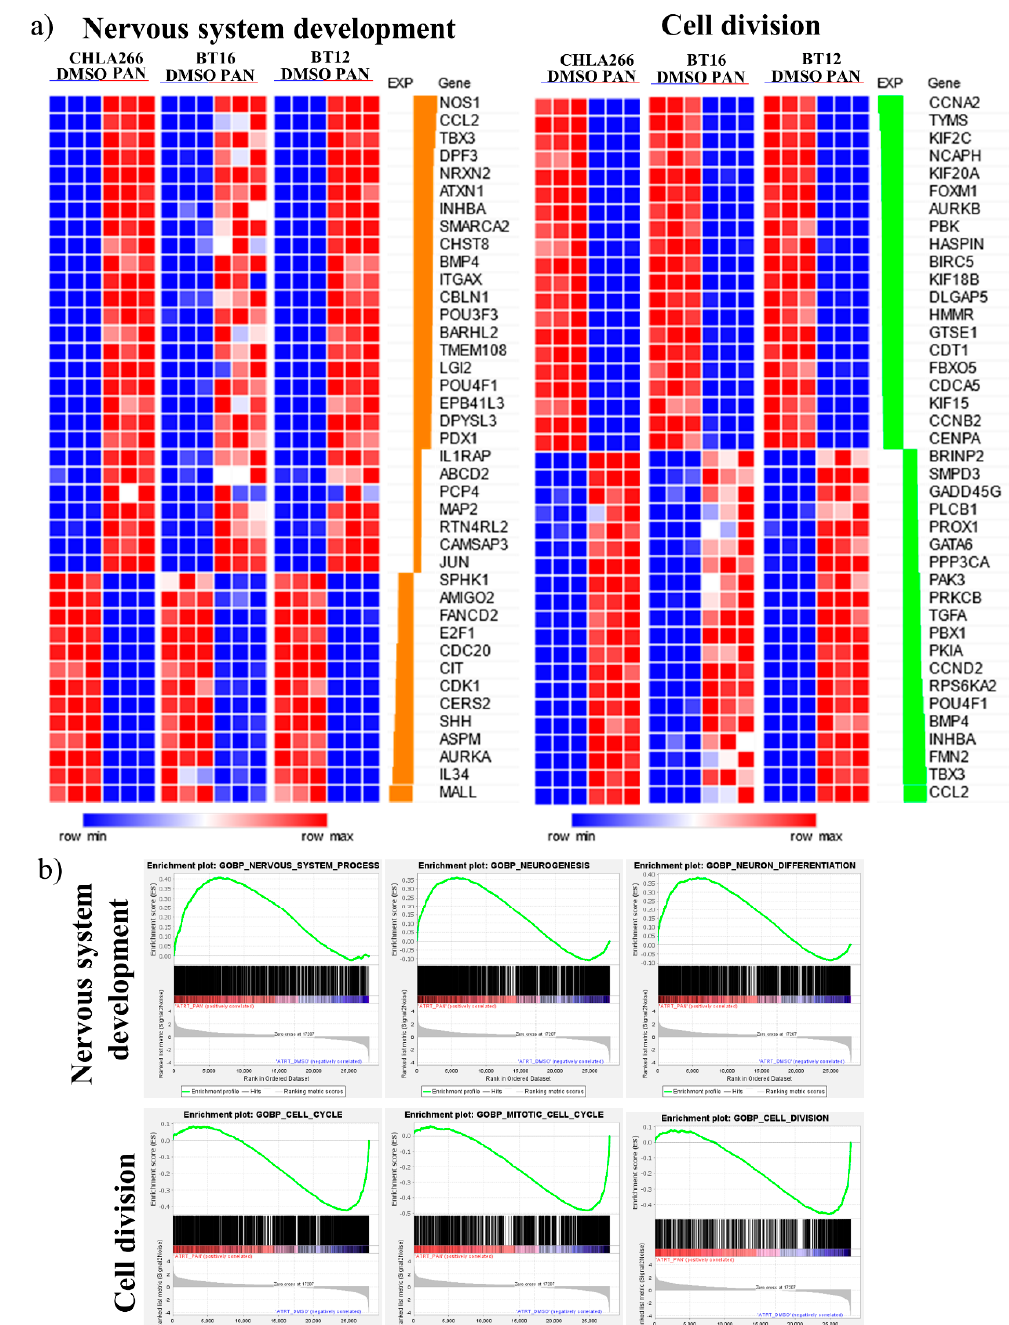
Figure 4. Sustained panobinostat treatment of ATRT cells regulates genes associated with nervous system development and cell division. ( a ) Heatmap representation of differentially expressed genes associated with nervous system development (left) and cell division processes (right). Each column represents a distinct sample and each row, a distinct gene. Level of expression is denoted by colour (blue, low; red, high). ( b ) GSEA enrichment plot of functional groups involved in nervous system development (top) and cell division processes